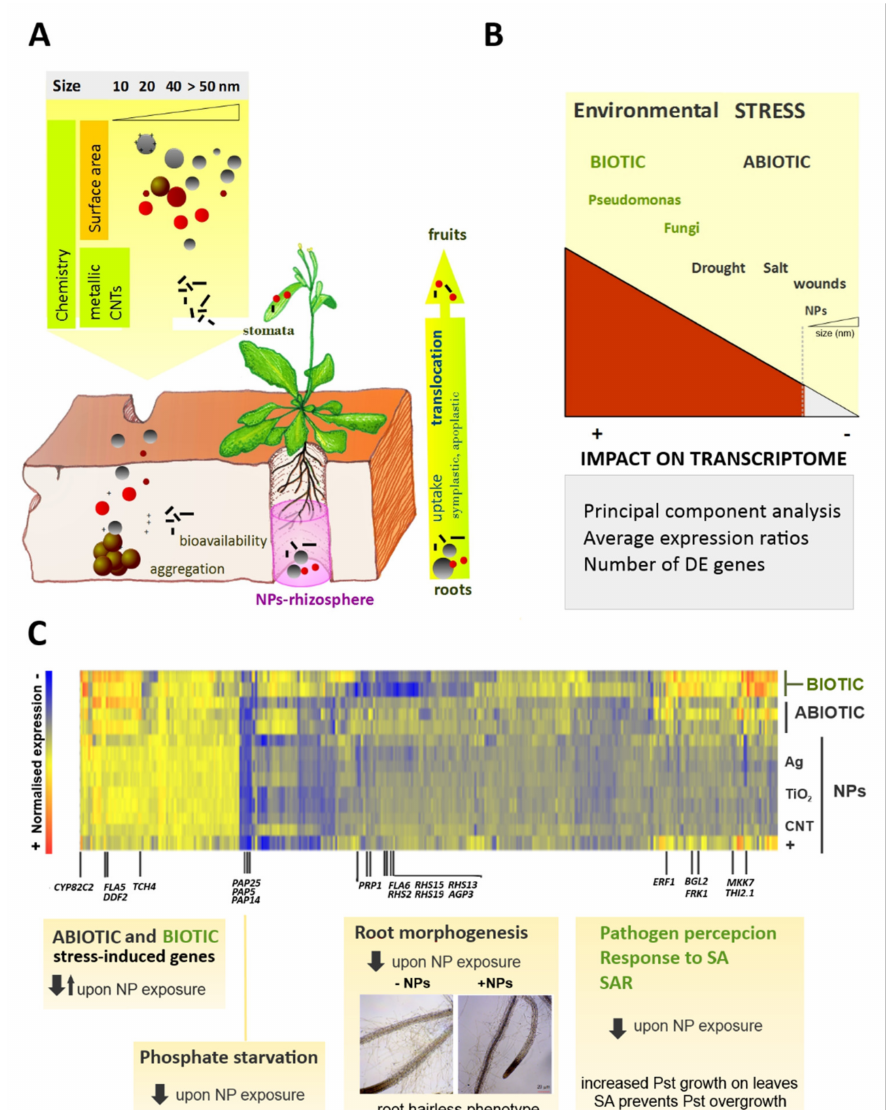
Figure 1. Transcriptomics approaches to evaluate nanoimpact in planta ( A ) Nanoparticles (NPs) released to the environment can enter into the biosphere and interact with plants, the primary producers in the food chain. NPs uptake occurs through the plant roots. These potentially toxic compounds can be translocated from the roots to the leaves and eventually reach the fruits. ( B ) The impact of NP exposure on plant transcriptome can be compared with other environmental challenges. Arabidopsis microarrays provided expression data for a large number of plant genes under different biotic or abiotic stress conditions, including early exposure to NPs. Unsupervised techniques like principal component analysis (PCA) summarize gene expression data and show that biotic stress is the main source of variation, whereas exposure to NPs causes little changes in the transcriptome. Comparative analyses of average expression ratios and the number of differentially expressed (DE) genes also support the low impact of NPs on the plant transcriptome. ( C ) DE genes were classified according to gene ontology (GO) categories, and enrichment was studied. The heat map shows the under-expression of genes involved in phosphate starvation, root morphogenesis, defense response to pathogens, and salicylic acid (SA) signaling. The expression of several genes that modulate systemic acquired resistance (SAR) is decreased upon NP treatment. Related phenotypes under NP exposure include a reduction in the number and length of root hairs and increased survival of Pseudomonas aeruginosa (Pst) in plant distal